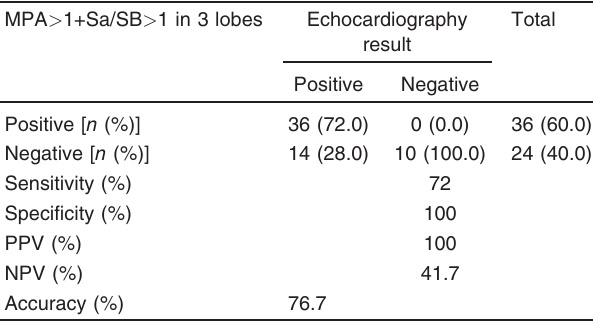
Table 13 Evaluation of different parameters: sensitivity, specificity, positive predictive value, and negative predictive value for main pulmonary artery more than 29+SA/SB more than 1 in three lobes in computed tomography scan MPA > 1+Sa/SB > 1 in 3 lobes